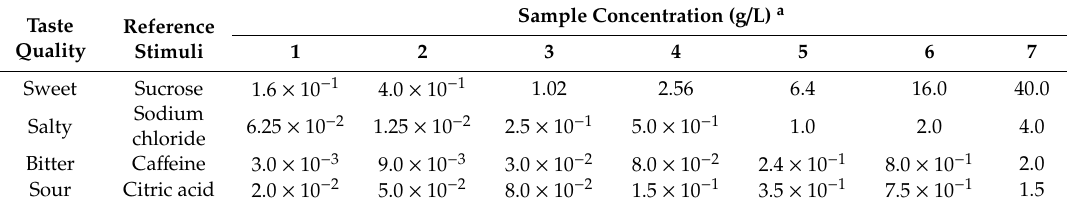
Table 1. Concentrations (g / L) of sucrose, sodium chloride, ca ff eine, and citric acid used to determine recognition